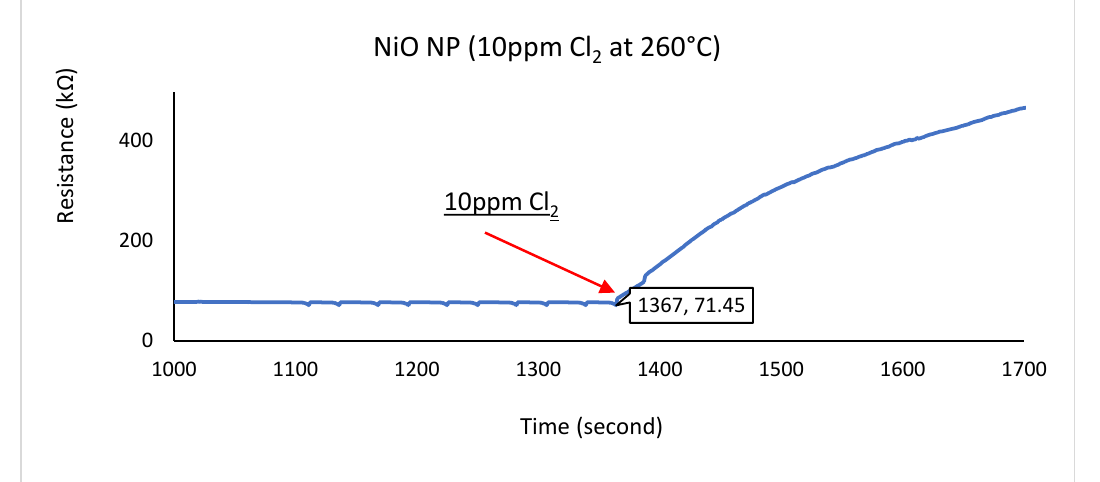
Figure 11. Cl 2 response for In 2 O 3 NS material at 260 °C.